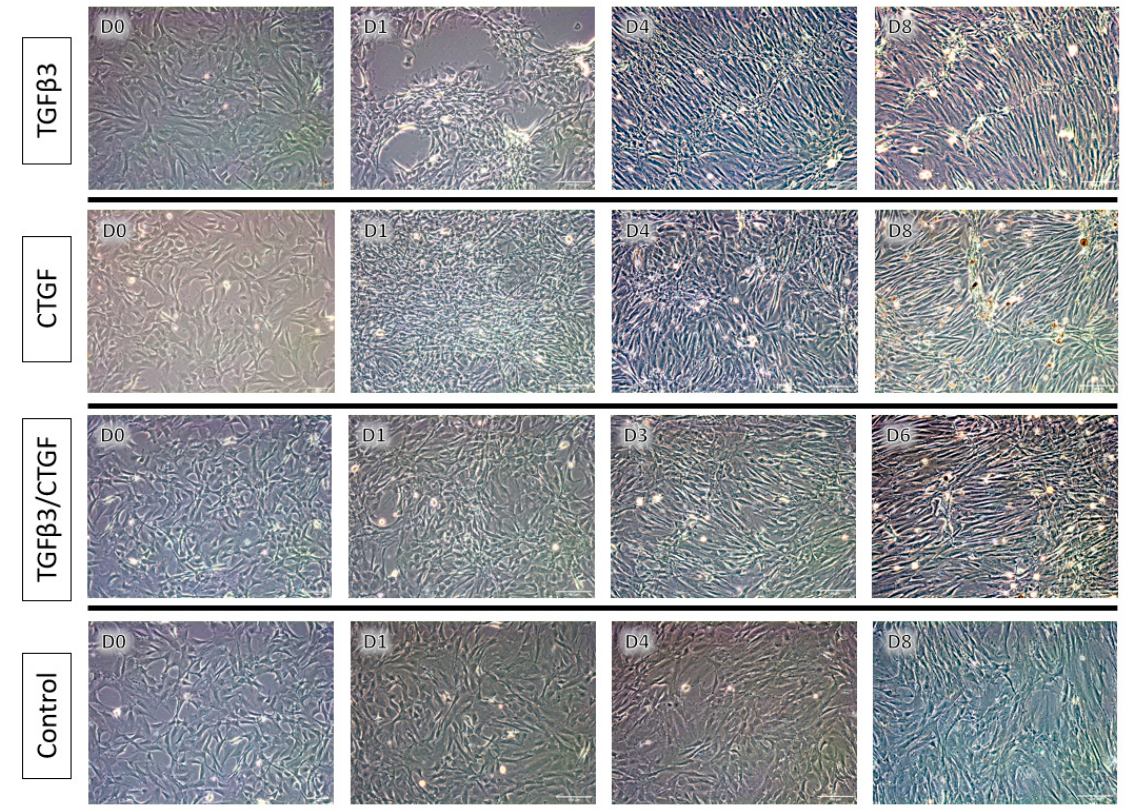
Figure 3. Tenogenic differentiation trial, bright light phase-contrast microscopy. rAdMSCs were maintained in complete medium alone (Control) or were exposed to either TGF- β 3 (10 ng/mL), CTGF (100 ng/mL) with 50 μ g/mL ascorbic acid, or TGF- β 3 (10 ng/mL), CTGF (100 ng/mL), and 50 μ g/mL ascorbic acid. Representative images from Days 0, 1, 4, and 8 of the Control, TGF- β 3, and CTGF groups and Days 0, 1, 3, and 6 of the TGF- β 3/CTGF group are depicted above to illustrate the change in cellular morphology, orientation, alignment, and extracellular matrix. Scale bar = 100 μ m.